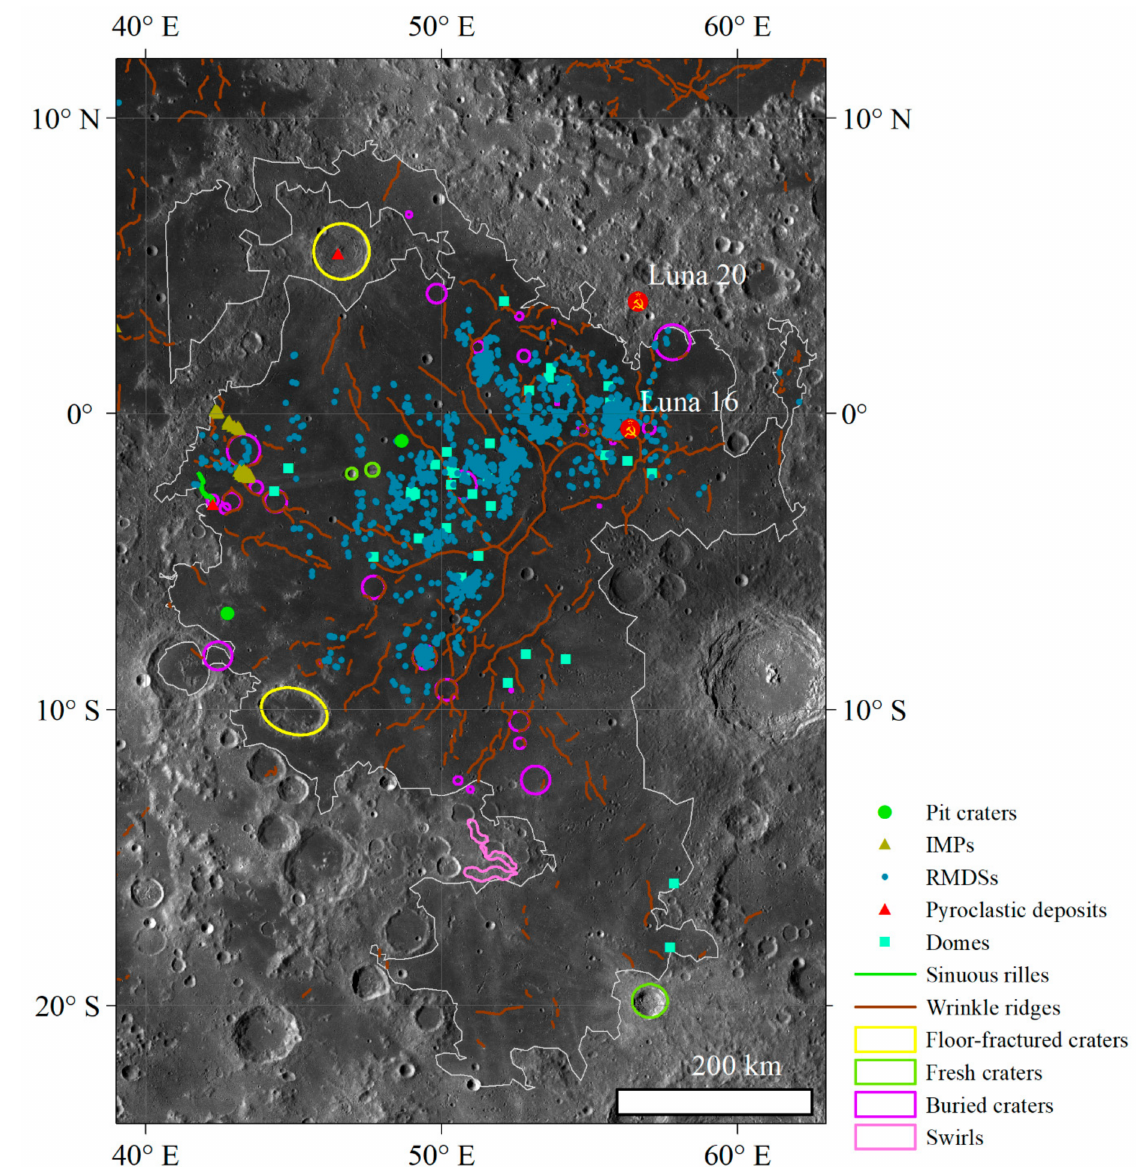
Figure 3. Geological features in Mare Fecunditatis, shown with a WAC image. The green points, dark yellow triangles, blue points, red triangles, bluish green boxes, green lines, brown lines, yellow outlines, green outlines, purple outlines, and pink outlines represent identified pit craters [14], IMPs (updated from [15]), RMDSs [16], pyroclastic deposits [17,18], domes, sinuous rilles [33], wrinkle ridges [34], floor-fractured craters [35], fresh craters [20], buried craters, and swirls [19],